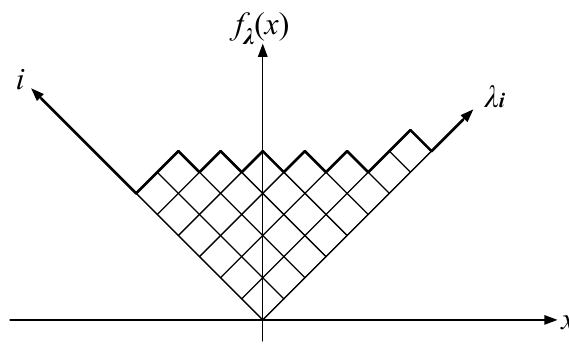
Figure 14 . Young diagram λ and its corresponding profile function f λ ( x )